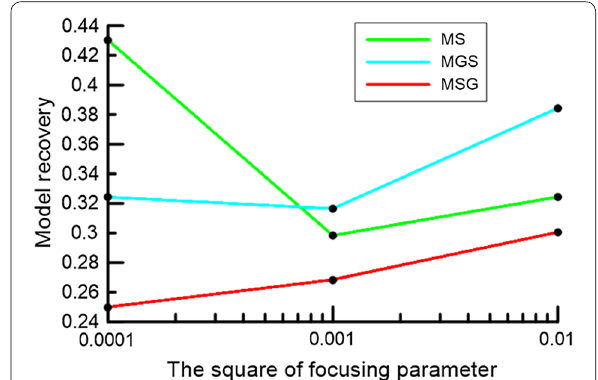
Fig. 13 The model recovery curve with different focusing parameters for the 2D resistive model (Fig. 6a)